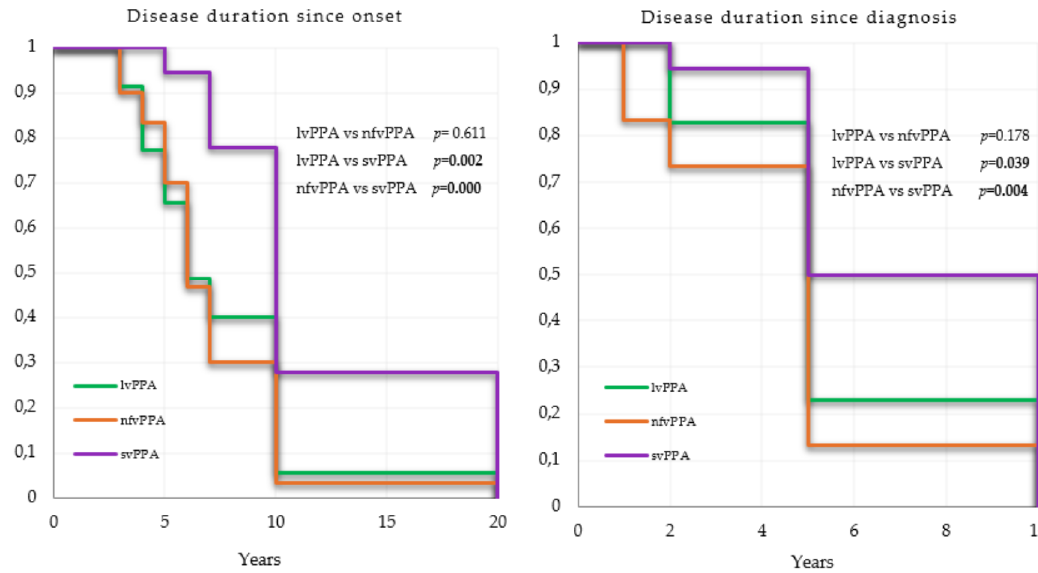
Figure 4. Kaplan–Meier survival curves. Table 3. Hazard ratios since onset.